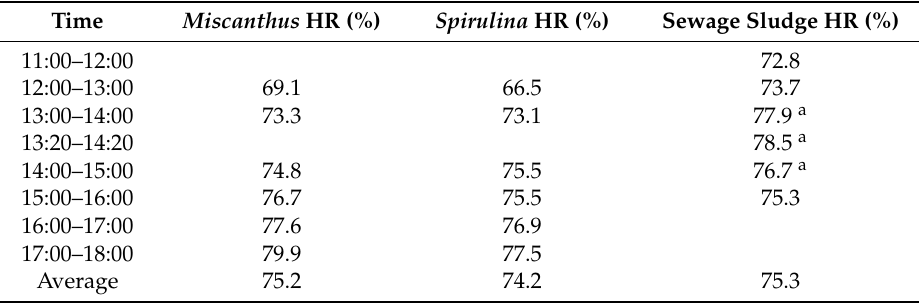
Table 3. Heat recovery (HR %) by the heat exchanger for HTL runs of the three biomass feedstocks.